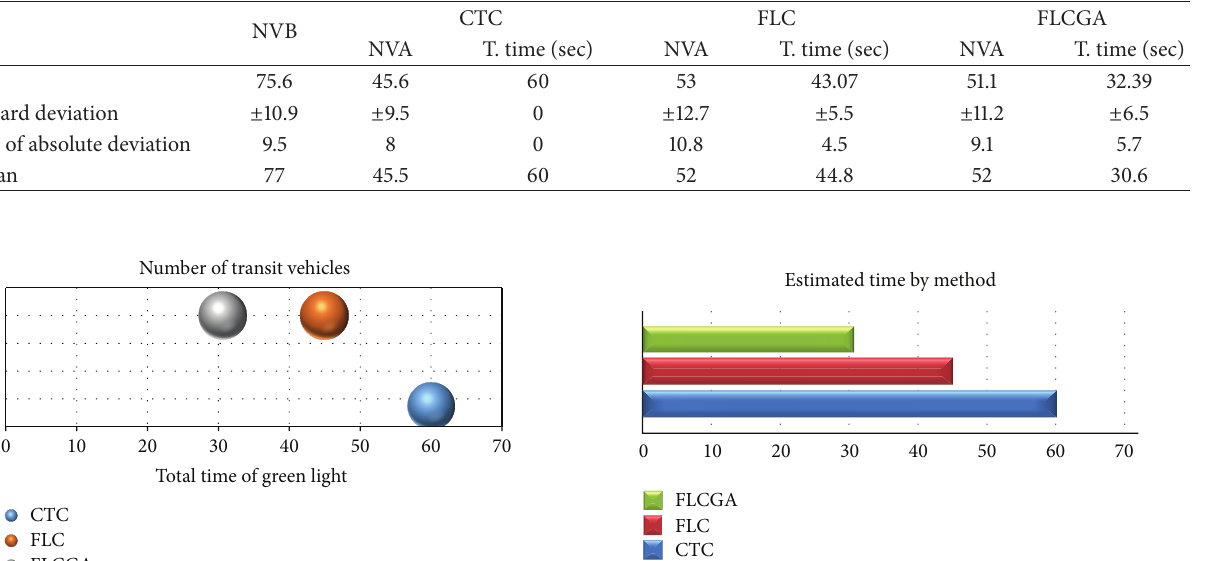
Table 2: Results of FLC with traditional logic method, Conventional Traffic Controller, CTC, and FLC with Genetic Algorithms, FLCGA. NVB is the number of vehicles that exists in the area of the four intersections before applying the method. NVA is the number of vehicles that exists after applying the method. The T. time is the summation of the total time of green lights time interval that was decided by the method.